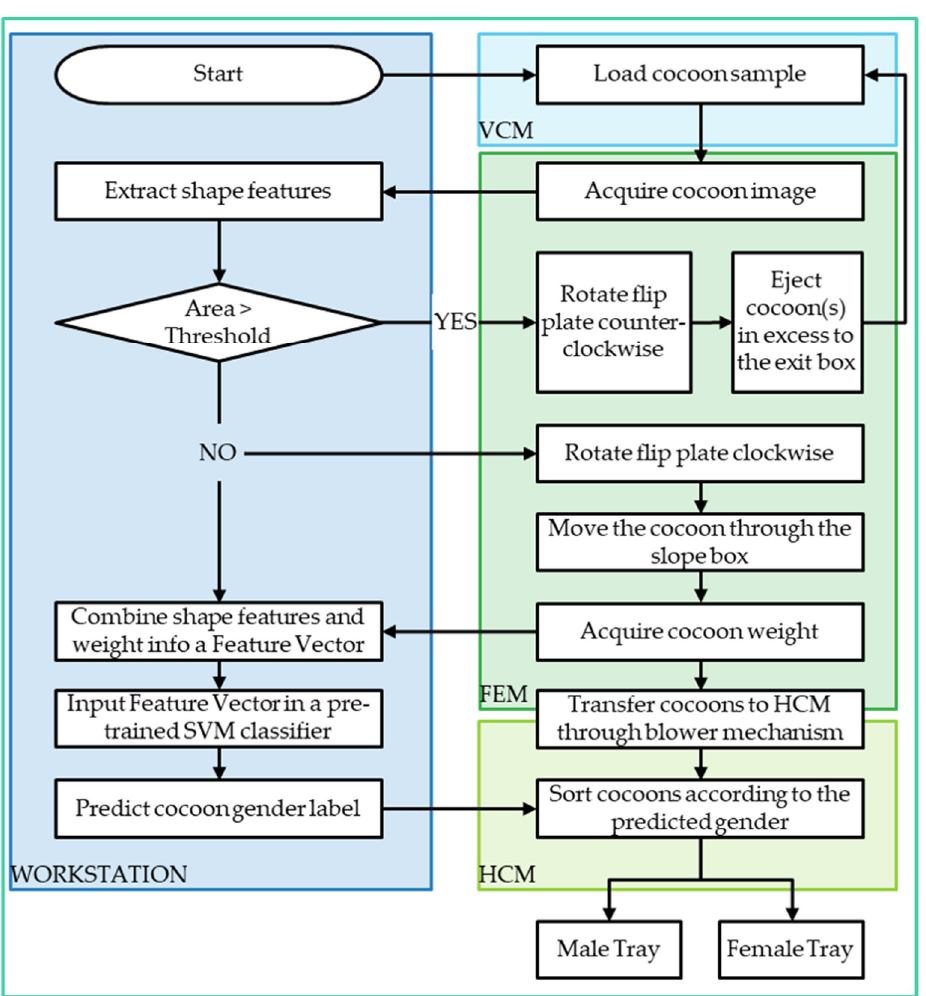
Figure 12. Flow diagram of silkworm cocoons gender classification machine.